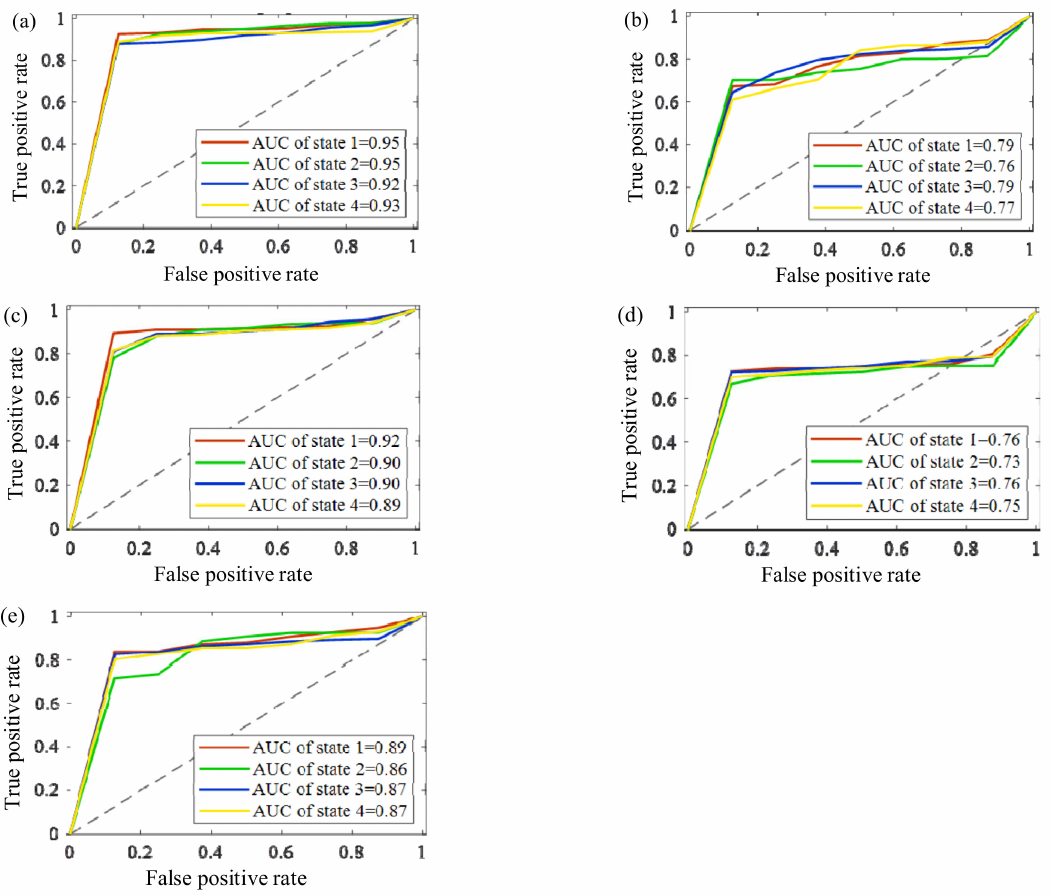
Figure 7. The ROCs and AUCs of the bearing states from the self-made IWM test stand by five methods: ( a ) proposed method, ( b ) AHNs, ( c ) K-AHNs, ( d ) SVM, ( e )